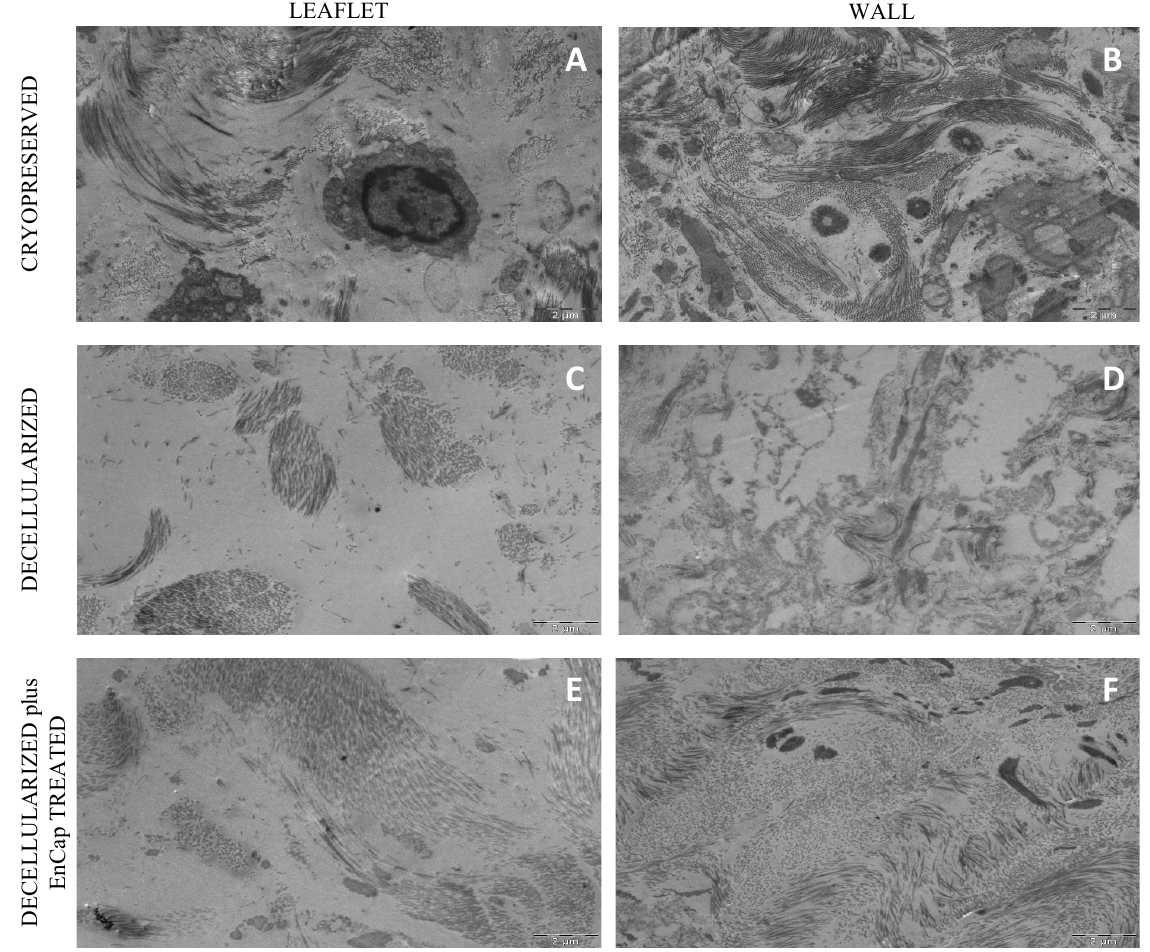
Figure 7. Representative transmission electron microscopy images of cryopreserved, decellularized, and decellularized and EnCap TM ‐ treated wall tissue processed after 48 h ischemia (( A – F ) = scale bar 2 μ m).